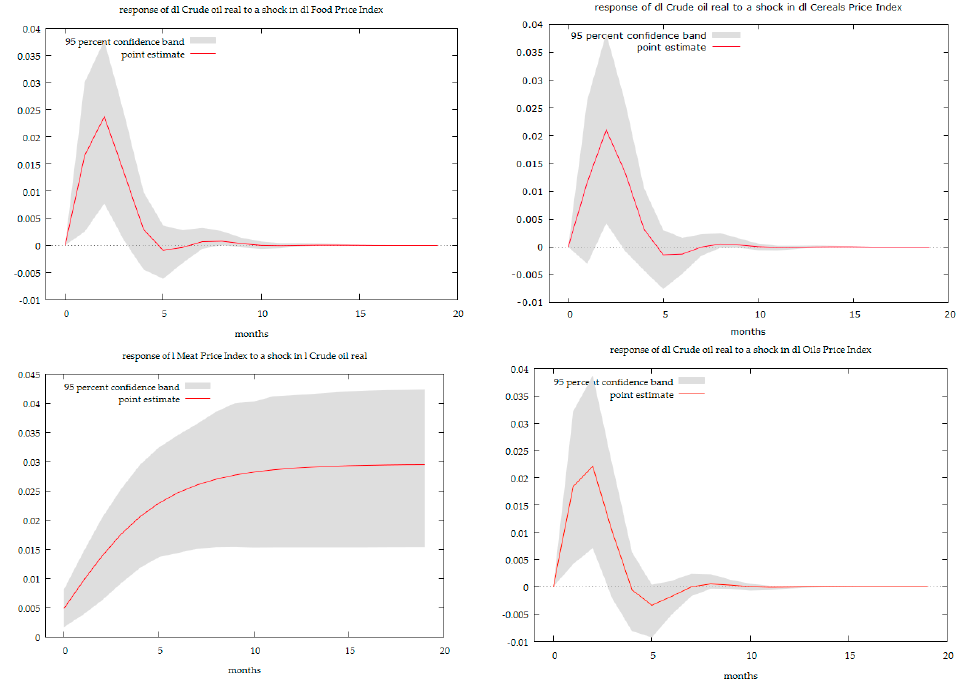
Figure 3. Impulse response function between crude oil price and selected food price volatility. Source: own calculations.